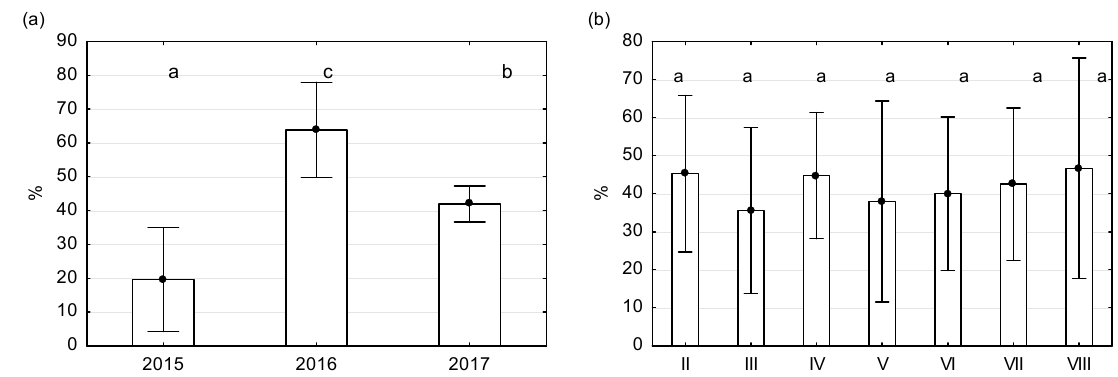
Figure 7. Recovery of N from fertilizers (R N ) depending on the years of the study ( a ) and applied fertilization ( b )—mean ± SE; data marked with same letters do not differ significantly at p < 0.05; figure ( a ) years of experiment (2015, 2016 and 2017), figure ( b ) number of object (II–VIII)—see Table 1. The weather conditions that varied between the years meant that the PNB values were different in the subsequent years (Figure 8a). In the dry year 2015 and in the very wet 2017, the low values of the PNB were observed (0.59 in 2015 and 0.69 kg kg − 1 in 2017). However, in the conditions that were optimal for the development of maize, such as in 2016, the BNP value reached 0.99 kg kg − 1 . On average for the three years of the experiment (Figure 8b), depending on the applied fertilization regimes, PNB ranged from 0.72 (fertilization with UAN + S/UAN + Mg) to 0.78 kg kg − 1 (UAN + P (Medium)/UAN + P (Medium).